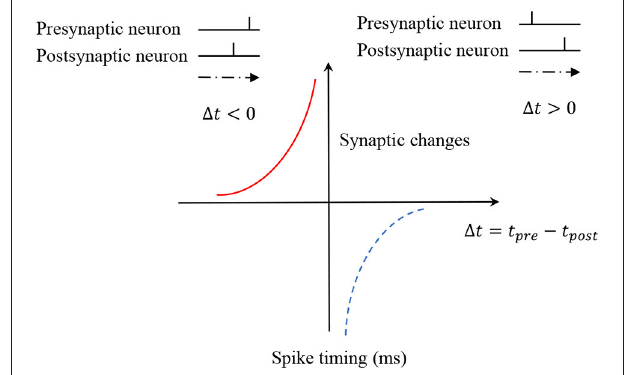
FIGURE 3 | The STDP learning rule. STDP consists of two update processes: LTD and